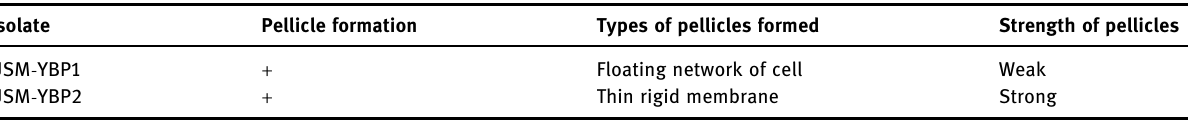
Table 2: Pellicle formation at the air – liquid interface of Hestrin – Schramm Broth culture Isolate Pellicle formation Types of pellicles formed Strength of pellicles USM - YBP1 + Floating network of cell Weak USM - YBP2 + Thin rigid membrane Strong Symbols: ( – ) indicates absence and (+) indicates presence.